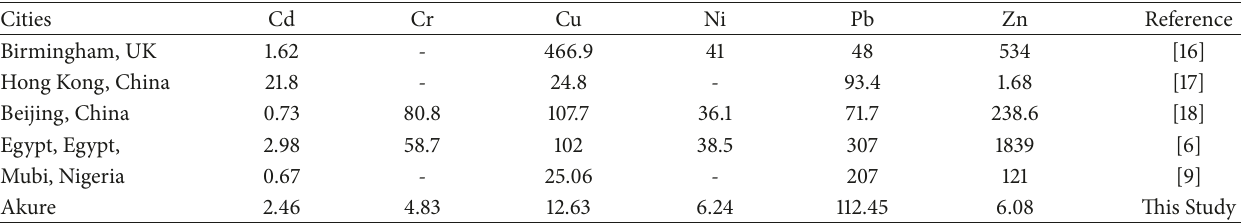
Table 5: Comparisons of heavy metal content ( 𝜇 gg −1 ) in street dust in this study with other cities of the world.